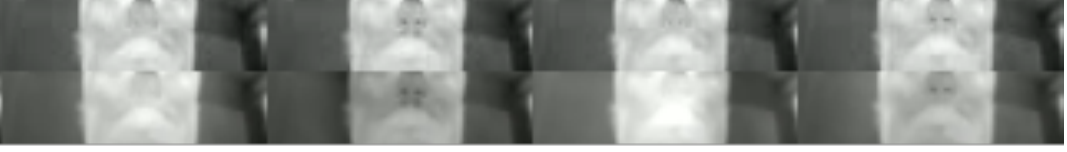
Figure 5. Example of frames extracted from the Lepton sequences enhanced with EVM algorithm. Top : original sequence, Bottom : enhanced sequence.